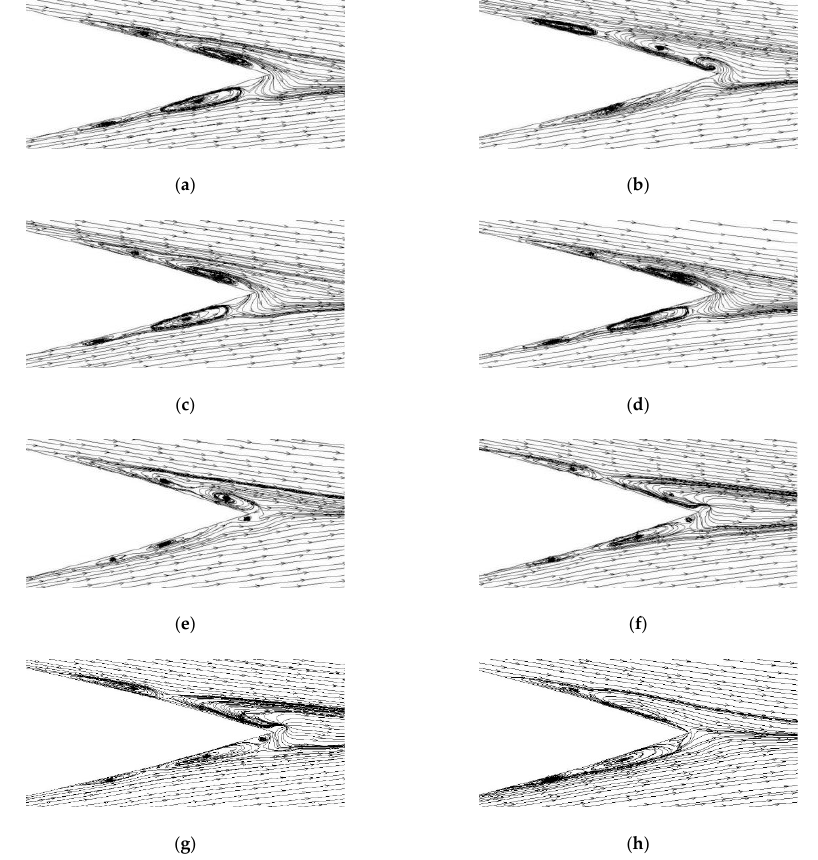
Figure 8. Diagram of the streamline at the trailing edge of the sail hull at different times: ( a ) 0.3125 s; ( b ) 0.625 s; ( c ) 0.9375 s; ( d ) 1.25 s; ( e ) 1.5625 s; ( f ) 1.875 s; ( g ) 2.1875 s; and ( h ) 2.5 s .